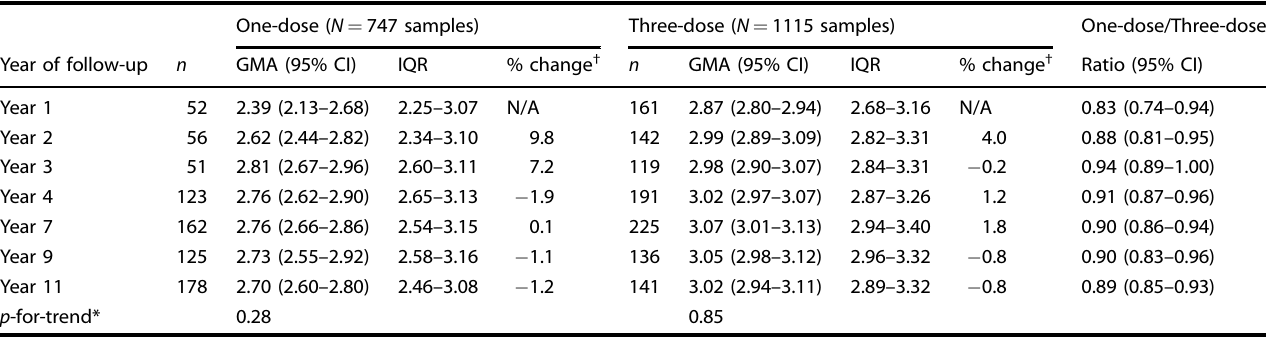
Table 1. Antibody avidity over time among one-dose and three-dose participants who were HPV16 seronegative at fi rst HPV vaccination. One-dose ( N = 747